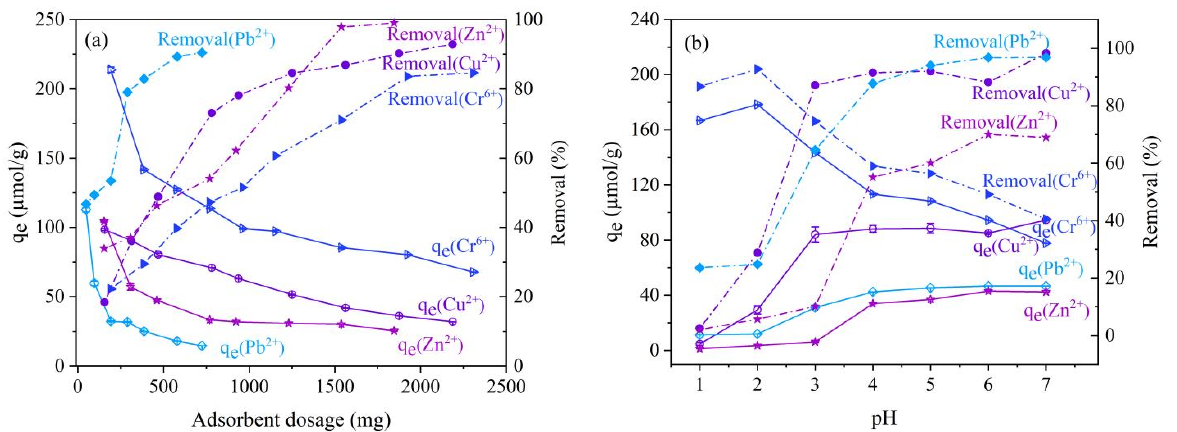
Figure 4. Effects of absorbent dosages ( a ) and solution pH ( b ) on the adsorption of Cr 6+ , Cu 2+ , Pb 2+ , and Zn 2+ onto magnetic nano-chitosan in aqueous solution.